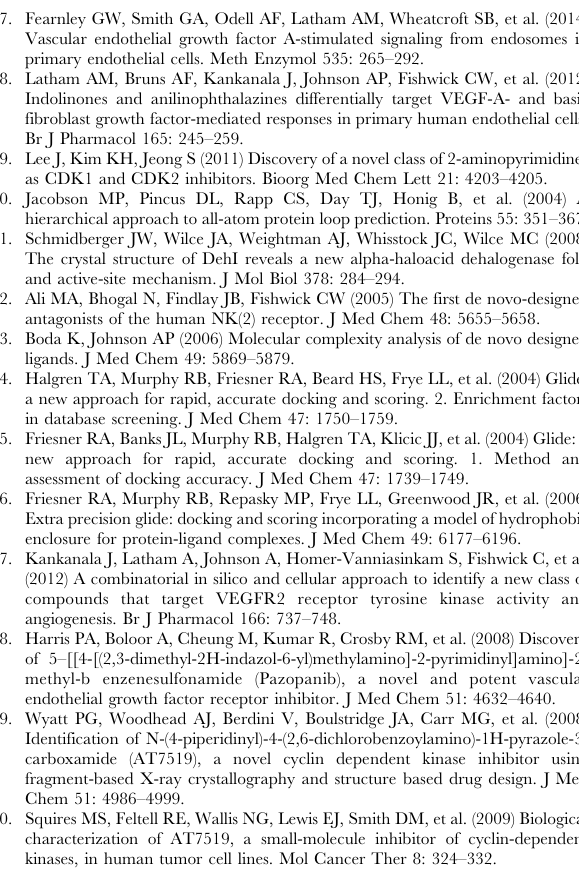
Figure S9 Quantification of the effects of JK-31 on cell cycle status in human breast cancer cells. Quantification and statistical analysis of (A) phospho-CDK1, (B) CDK1, (C) Cyclin B and (D), Cyclin A levels in human breast cancer cells treated with nocodazole, bohemine, sutinib and JK-31 for 48 h. Statistics presented relative to ansynchronous conrtrols. Error bars represent 6 SEM (n =3). * p , 0.05; ** p , 0.01; *** p , 0.001. (TIF) Figure S10 Quantification of the effects of nocodazole treatment on cell cycle progression in endothelial and human breast cancer cells. Quantification and statistical analysis of cell cycle progression in (A) endothelial (HUVEC) or (B) epithelial (MCF-7) cells upon treatment with 200 nM nocodazole for 48 h. Statistics presented relative to ansynchronous (ASYNCHR) controls. Error bars represent 6 SEM (n= 3). *** p , 0.001; **** p , 0.0001.